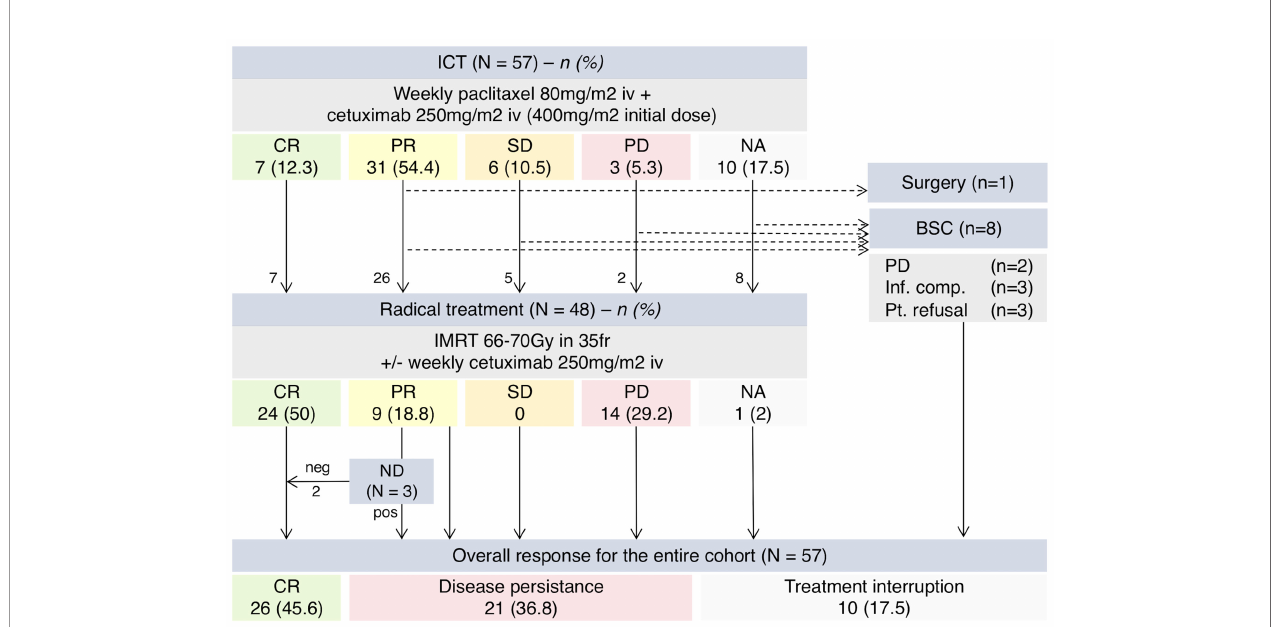
FIGURE 2 | Schema summarizing treatment received and ORR. ICT, induction chemotherapy; ND, neck dissection; CR, complete response; PR, partial response; SD, stable disease; PD, progressive disease; NA, not available; BSC, best supportive care; Inf. Comp., infectious complications; Pt., patient.